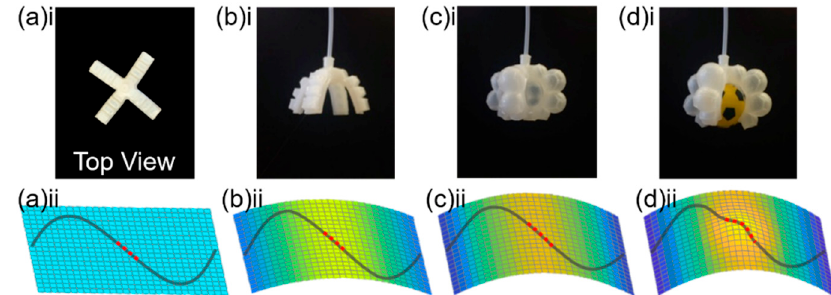
Figure 3. Soft robotic gripper at different operation states. (a)i Top view of gripper resting on a flat surface; (a)ii strain distribution in the soft gripper arm, where the gray solid curve is the optical fiber and the dashed red line is the position of the FBG; ( b ) natural bend; ( c ) gripper actuated without holding an object; and ( d ) the gripper actuated and holding a sphere.